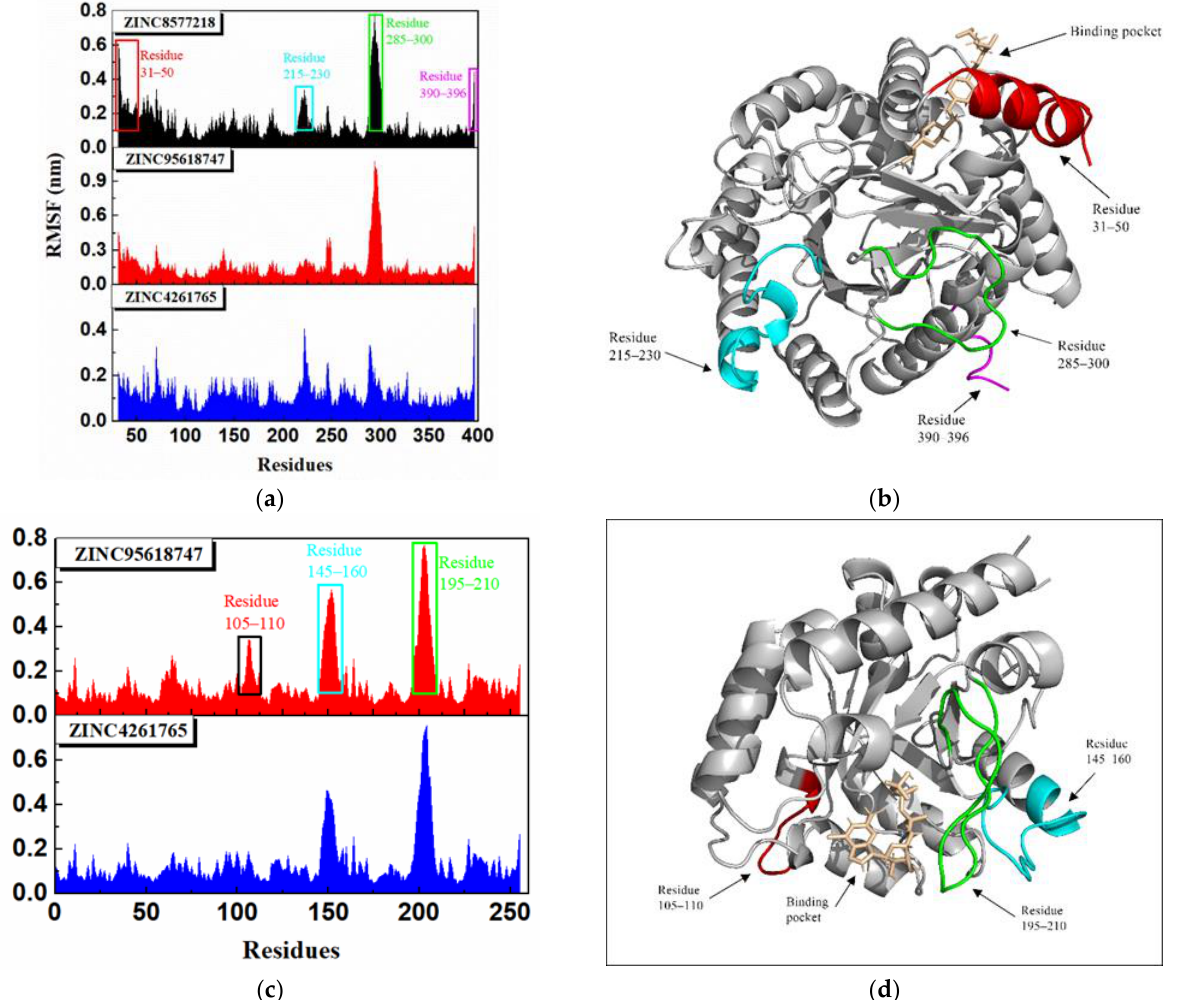
Figure 18. Root-mean-square fluctuation (RMSF) analysis of each receptor–ligand complex in molecular dynamics simulation. ( a ) RMSF of DHODH complexes. ( b ) The unstable region of the DHODH protein combined with ZINC8577218. ( c ) RMSF of UMPS complexes. ( d ) The unstable region of the UMPS protein combined with ZINC95618747.